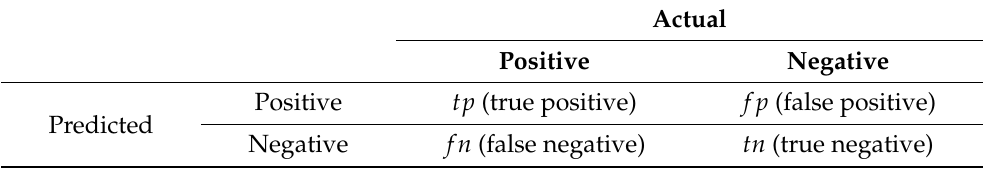
Table 1. The confusion matrix elements used to define metrix of classification models